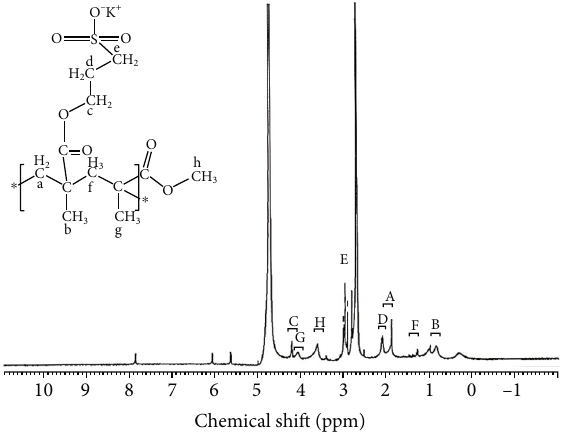
Figure 3: 1 H-NMR of PSM50 copolymer of P(SPMA-co-MMA).